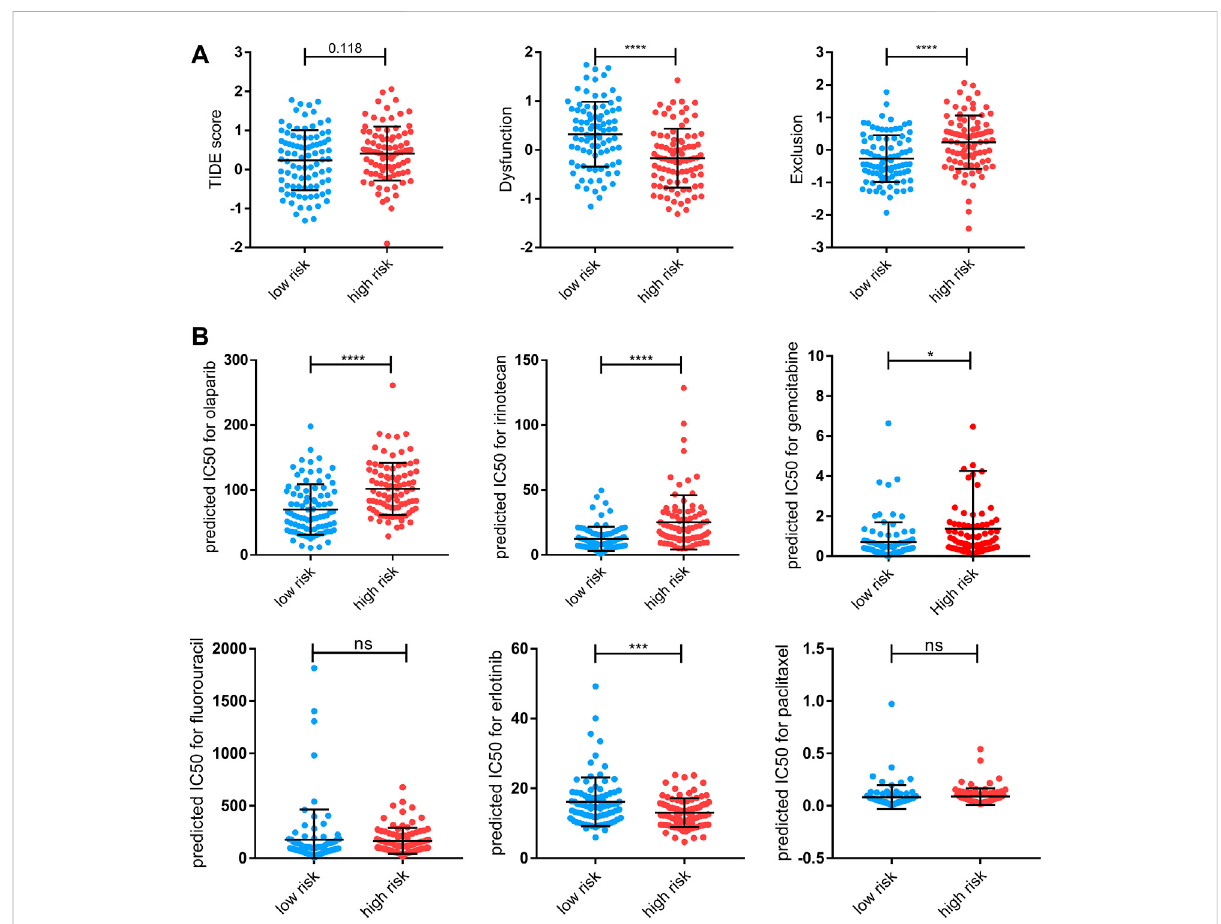
FIGURE 9 Therapy response features underlying the PRGs model. (A) Comparison of TIDE score, T-cell dysfunction ( “ Dysfunction ” ) score, and T-cell exclusion ( “ Exclusion ” ) scores between the high- and low-risk groups of the TCGA cohort. (B) Predicted IC50 for olaparib, irinotecan, gemcitabine, fl uorouracil, erlotinib, and paclitaxel for low-risk and high-risk groups. Data shown are means ± SD. Symbols represent the individual patients. Signi fi cant was determined using the Mann-Whitney or unpaired t -test. * p < 0.05 ** p < 0.005, *** p < 0.0005, and **** p <